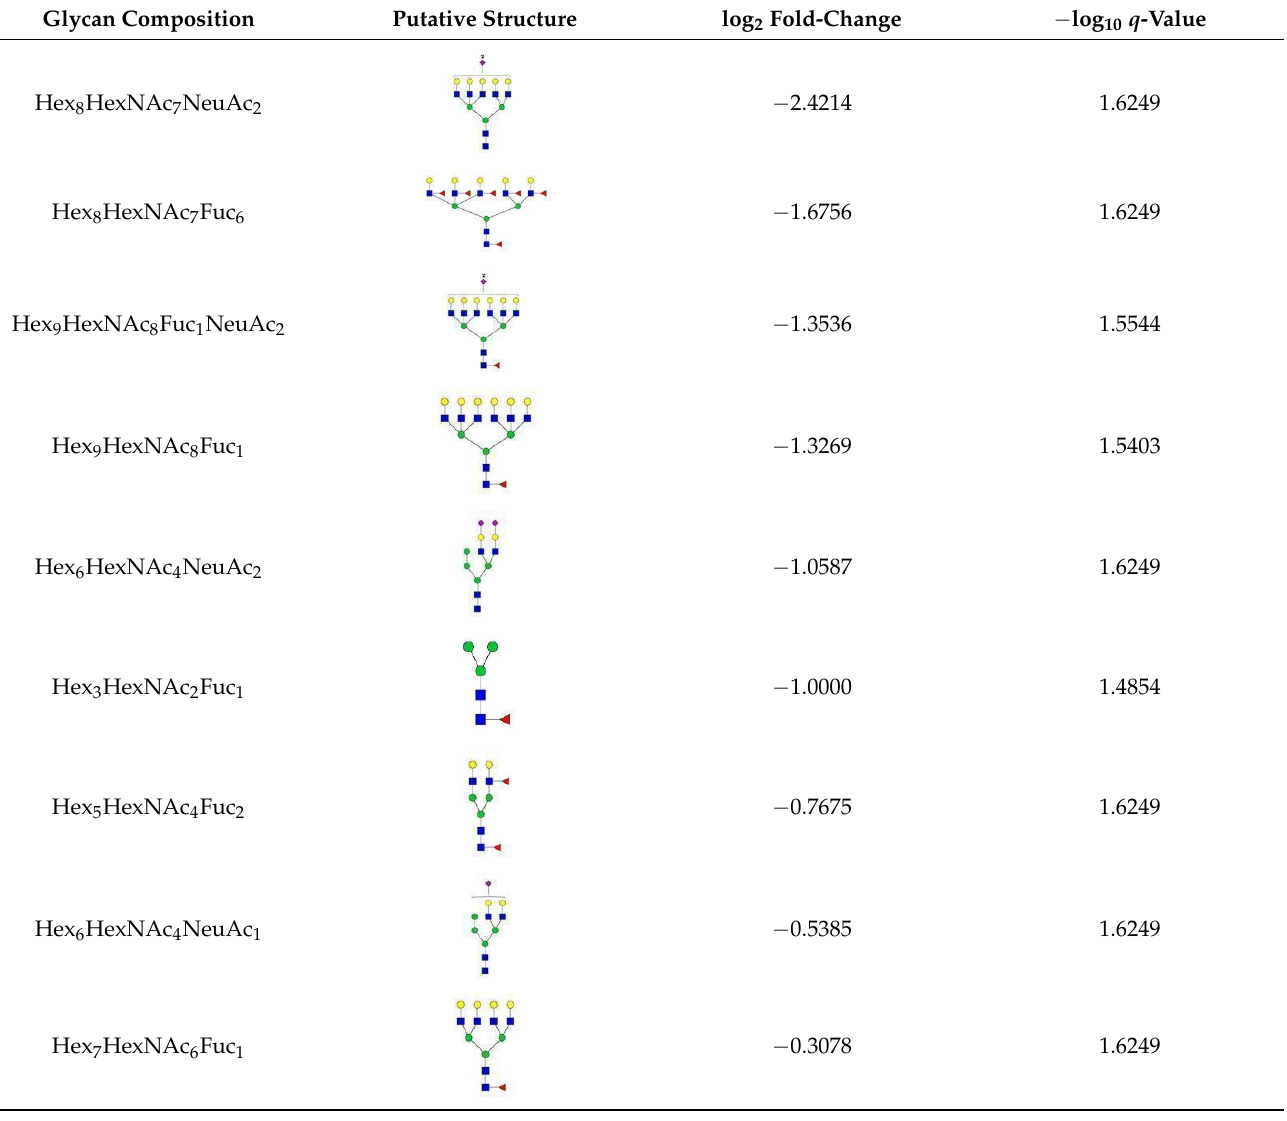
Table 1. Glycan composition, putative structures, and log 2 fold-change (and q -values) of highly significantly different glycans in pictilisib-treated A549 cells compared to vehicle control.